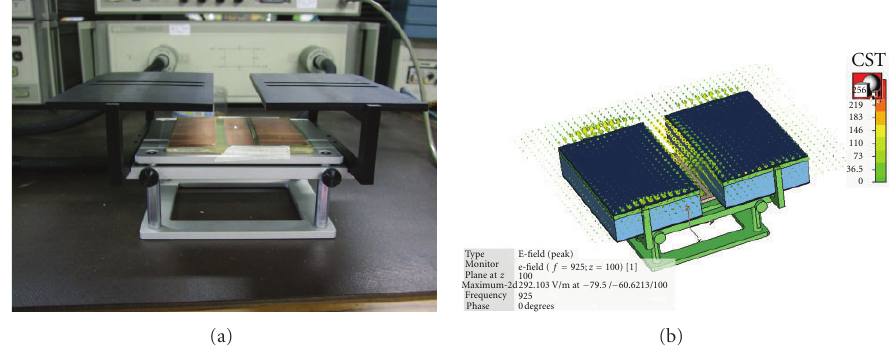
Figure 8: The laboratory fixture for testing.